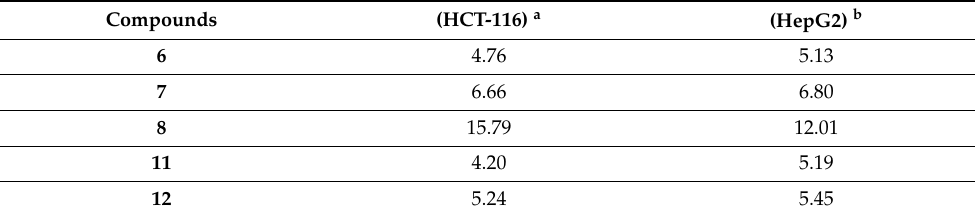
Table 3. Selectivity indices (SI) of the synthesized compounds against different cancer cell lines.